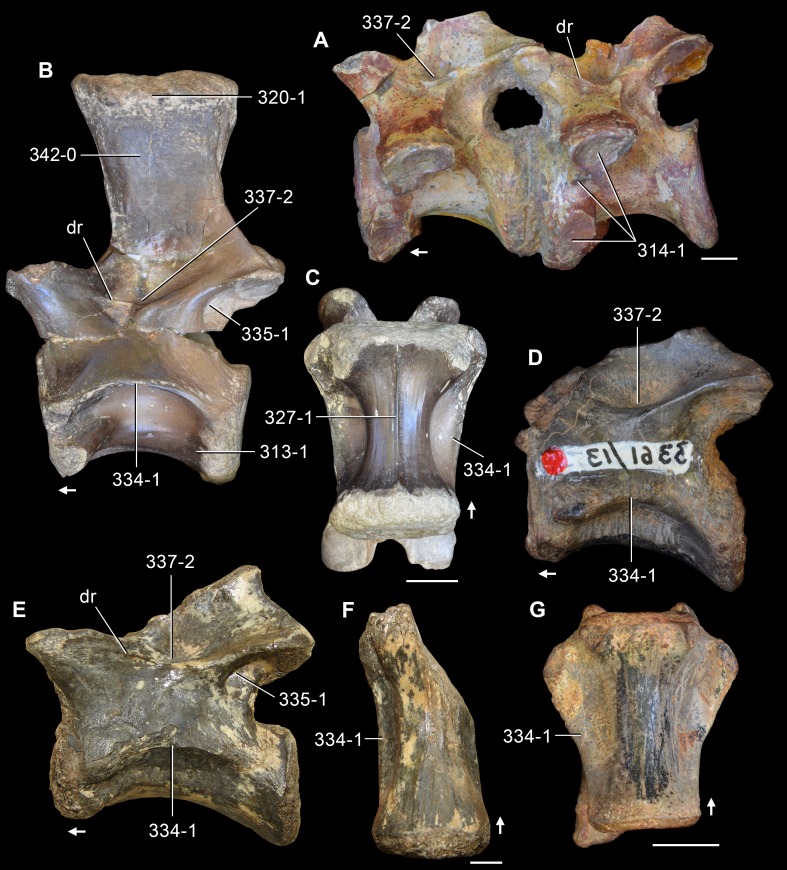
Chasmatosuchus rossicus.(A) holotype posterior cervical vertebrae (PIN 2252/381) and (B, C: PIN 3200/217; E, F: PIN 2424/6, holotype of Tsylmosuchus samariensis, mirrored) referred anterior cervical vertebrae; and Chasmatosuchus magnus (D, G) referred anterior cervical vertebra (PIN 3361/13, holotype of “Gamosaurus lozovskii,” mirrored) in left lateral (A, B), ventral (C, F, G), and right lateral (D, E) views. Numbers indicate character-states scored in the data matrix and the arrows indicate anterior direction. Abbreviation: dr, diagonal ridge. Scale bars equal 5 mm.